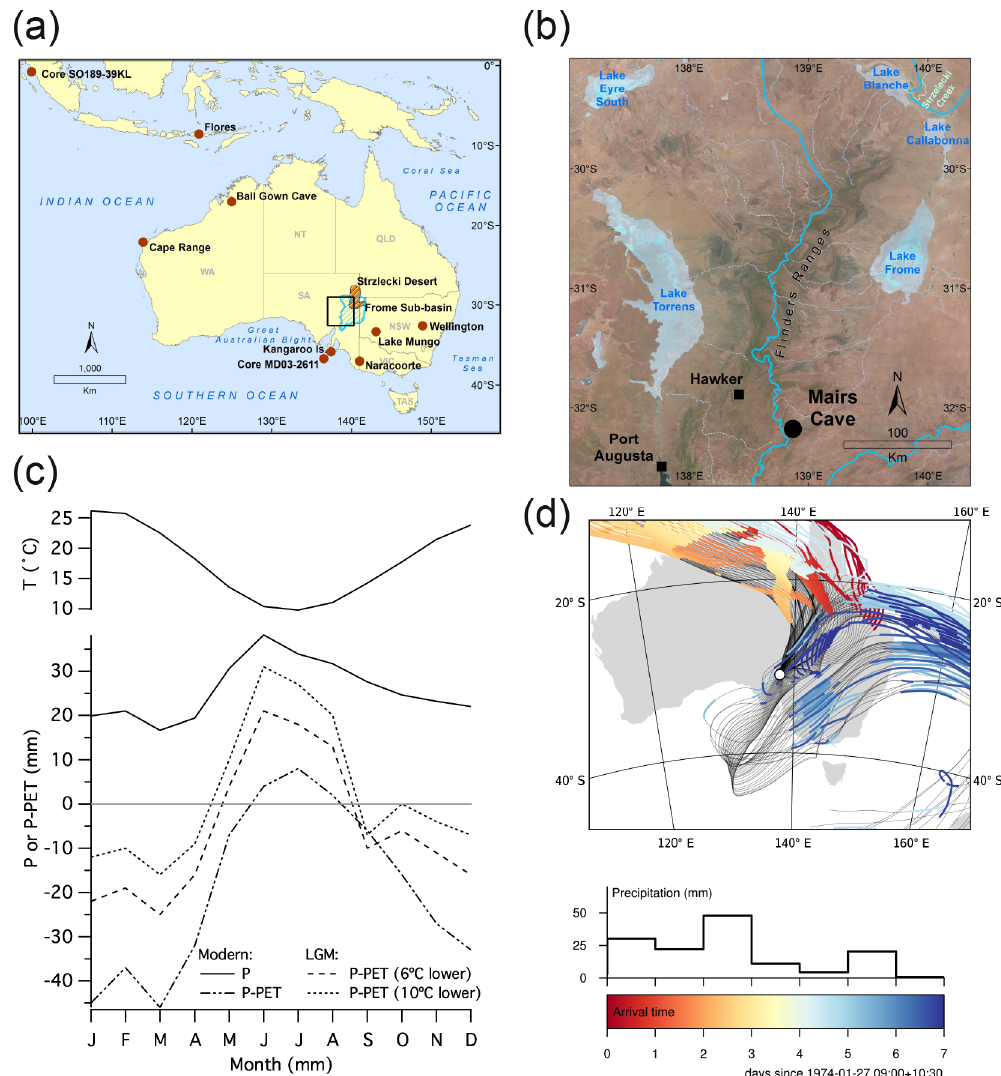
Figure 1. Location of the Flinders Ranges and other sites described in the text (a) ; location of Mairs Cave, Flinders Silts, and Lake Frome (b) ; monthly climate statistics for Hawker (approximately 60km from Mairs Cave) and hydrologically effective precipitation or P-PET calculated using the Thornthwaite method for modern-day and LGM scenarios of 6 or 10 ◦ C temperature cooling (c) ; and air mass back trajectories for 27 January to 3 February 1974 (upper panel) and daily precipitation (lower panel) (d) . Back trajectories are 10 days long, ending at Mairs Cave and 1500ma.g.l. Meteorological forcing is derived from the 2.5 ◦ NCEP/NCAR Reanalysis (Kalnay et al., 1996). Trajectories are colour-coded according to arrival time but only during intervals when the air mass is beneath the surface boundary layer to indicate potential moisture sources – i.e. we interpret the source of moisture for air masses arriving between days 4 and 7 to be the Pacific (below boundary layer) rather than the Southern Ocean (above boundary layer). Precipitation is the average of 13 stations within 50km of